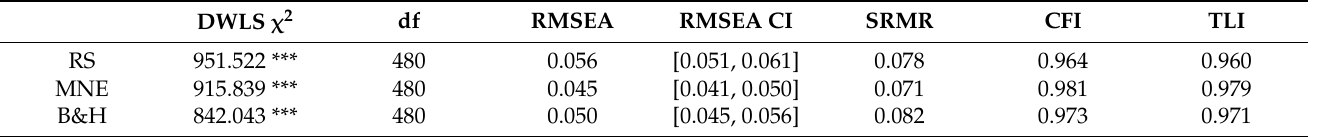
Table 3. Fit indices for the six-factor model of the original DAS in RS, MNE and